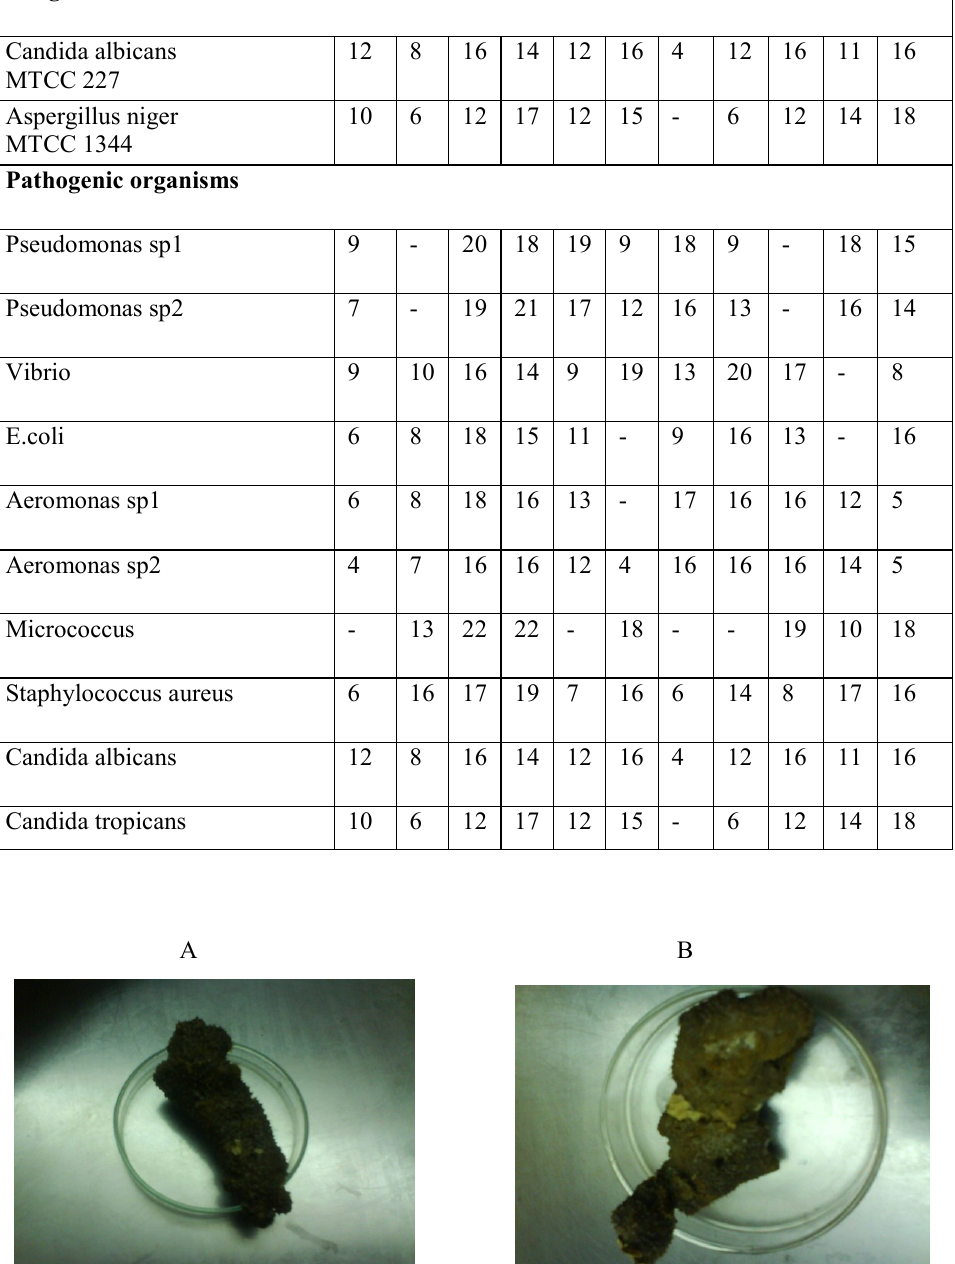
Figure 1. A. Fasciospongia cavernosa doc brown, B . Fasciospongia cavernosa doc